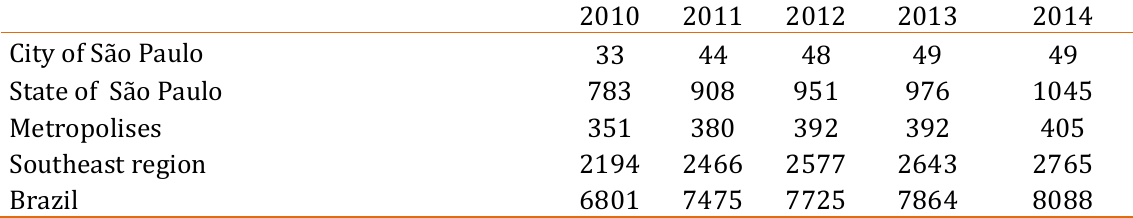
Table 01. Number of Basic public facilities (CRAS),